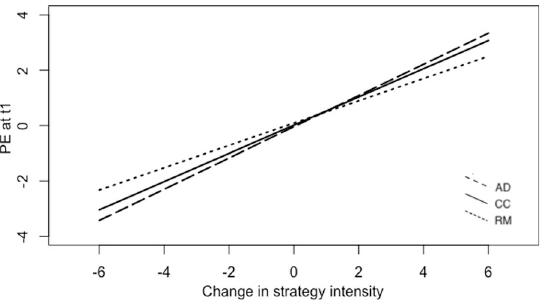
Fig 1. Graphical representation of the effect of change in strategy use on subsequent positive emotions, moderated by strategy category (PE = positive emotions).